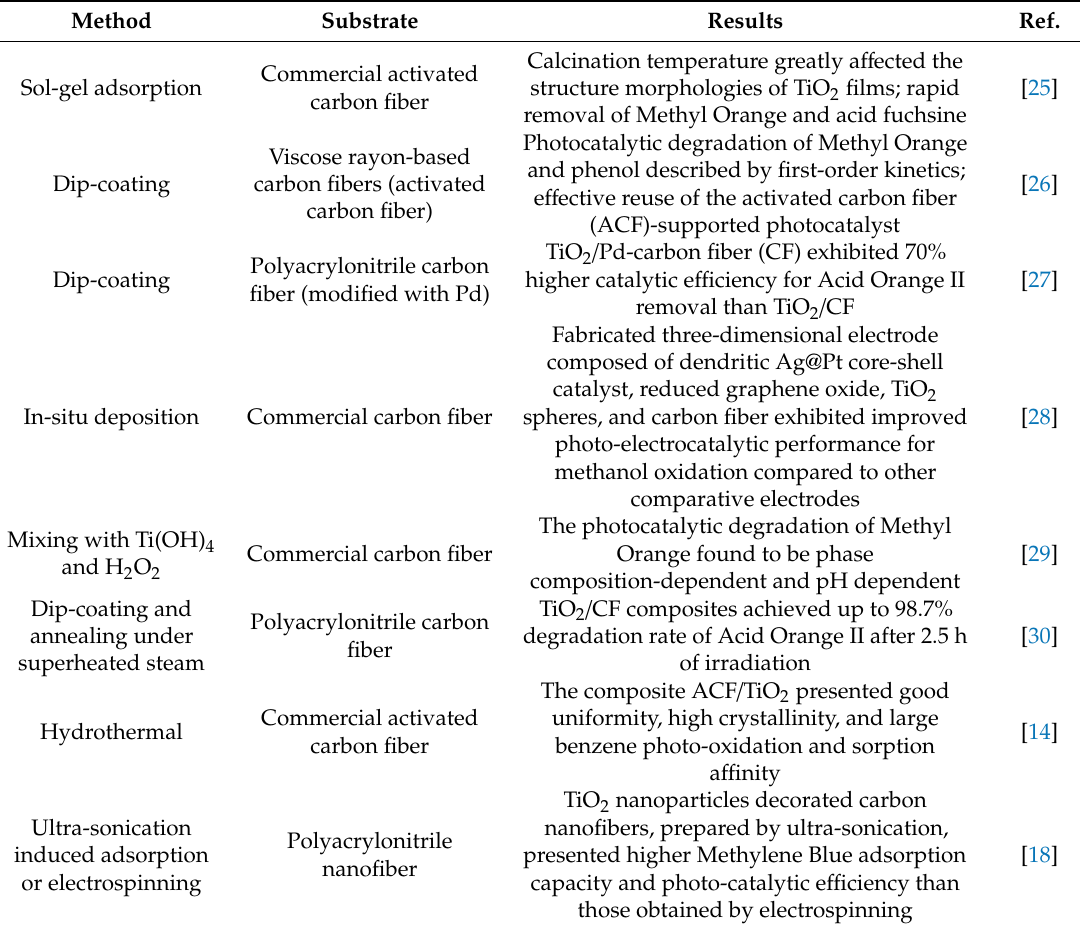
Table 1. Methods of TiO 2 immobilization on carbon fiber